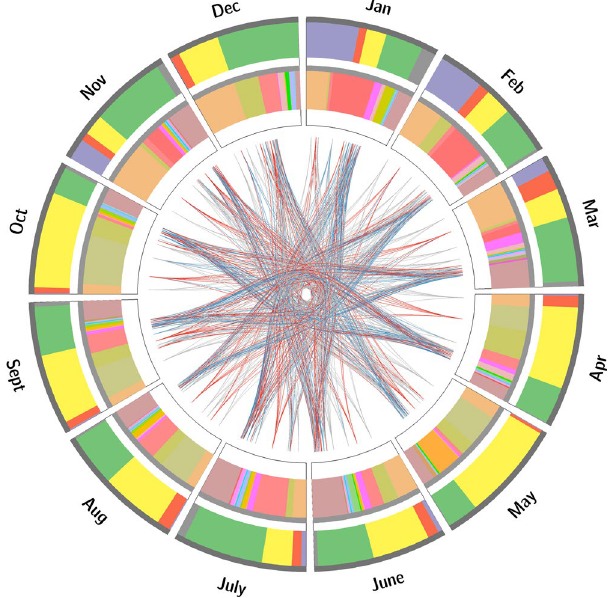
Figure 6. The complex illustrations showing the major phyla and genera in 12 months and the significant differences between major genera among 12 months. (1) The outer circle showed the phylum level and percentage of major phyla, purple: Actinobacteria , red: Bacteroidetes , yellow: Firmicutes , green: Proteobacteria , grey: other phyla. (2) The inner circle showed the genus level and percentage of major genera which accounting for at least 1% and had significant difference (Q-value < 1E-5) between months. (3) The lines linked the different months showed the major genera difference, red line: fold change > 50, blue line: 50 ≥ fold change > 10, grey line: 10 ≥ fold change > 2, and more details were showed in the supplementary Tables